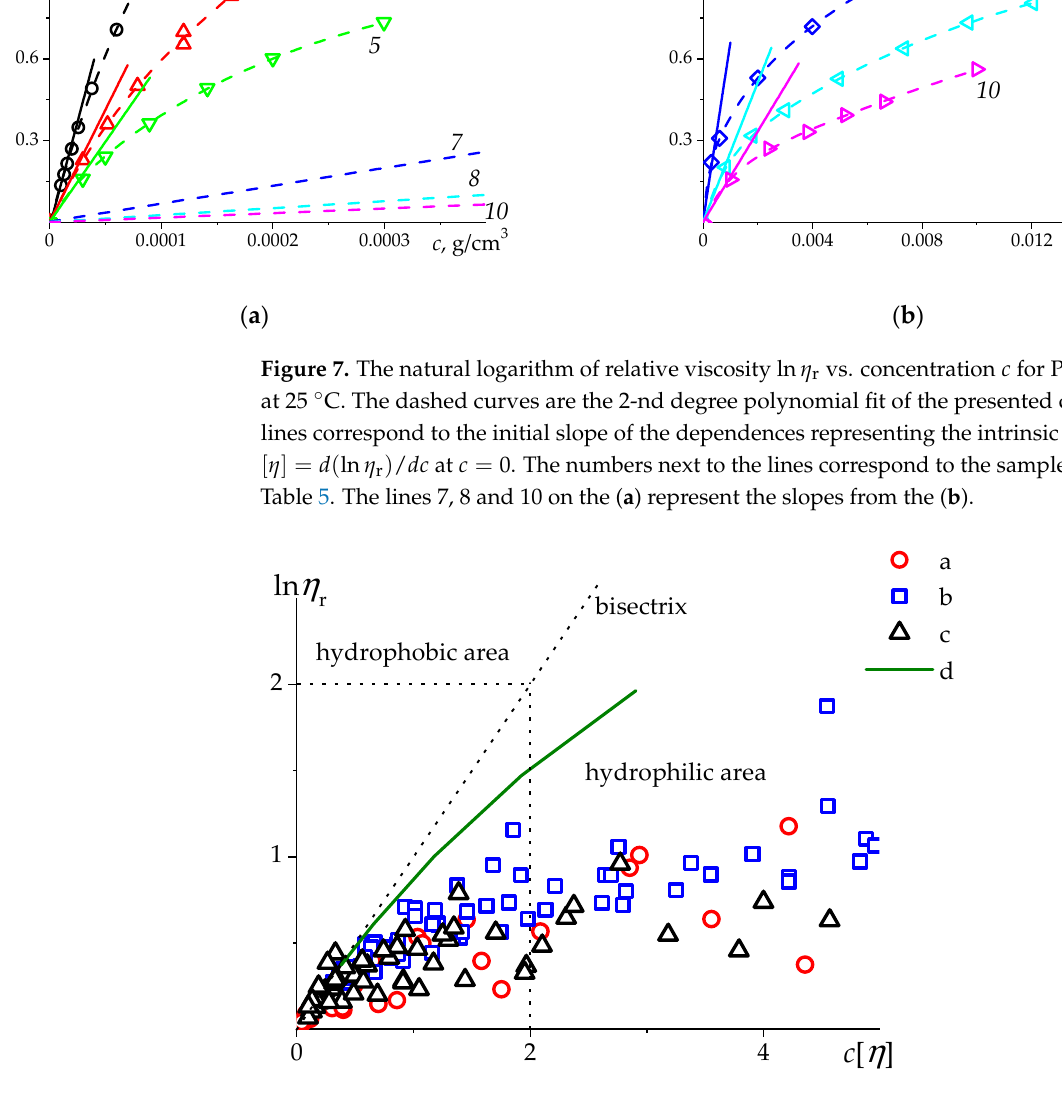
Figure 8. The dependence of natural logarithm of relative viscosity ln η r on dilution degree c [ η ] re- solved in H 2 O solution for PSSNa (a—[51], b—[54]), MVAA- co -MVAC 12 H 25 (c—[55], and PMVA [57] (d, sample 4 in Table 1). Dashed line is the bisectrix of current coordinates (i.e., line ln η r = c [ η ] ).